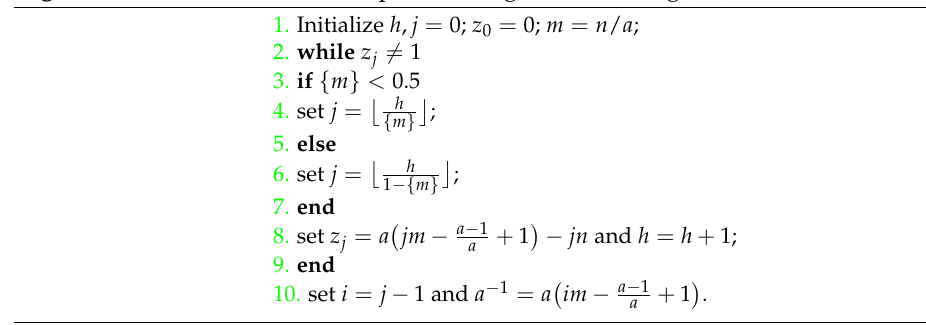
Algorithm 2 Pseudocode of the optimized algorithm solving